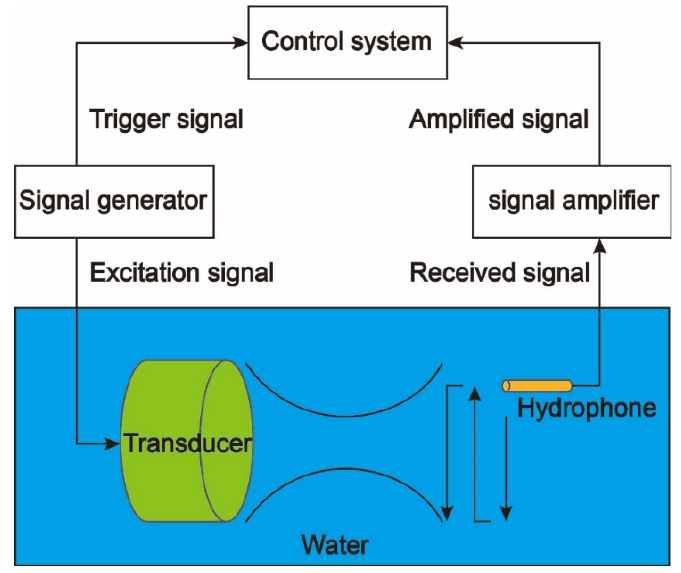
Figure 8. Schematic diagram of 3D ultrasound intensity measurement system.